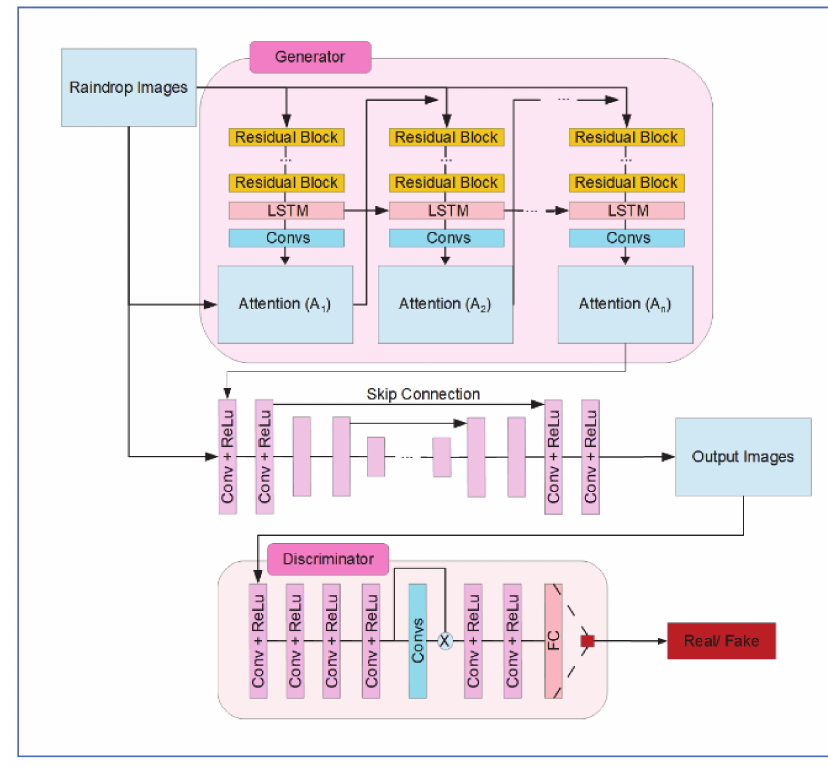
Figure 21. The architecture of Attentive GAN